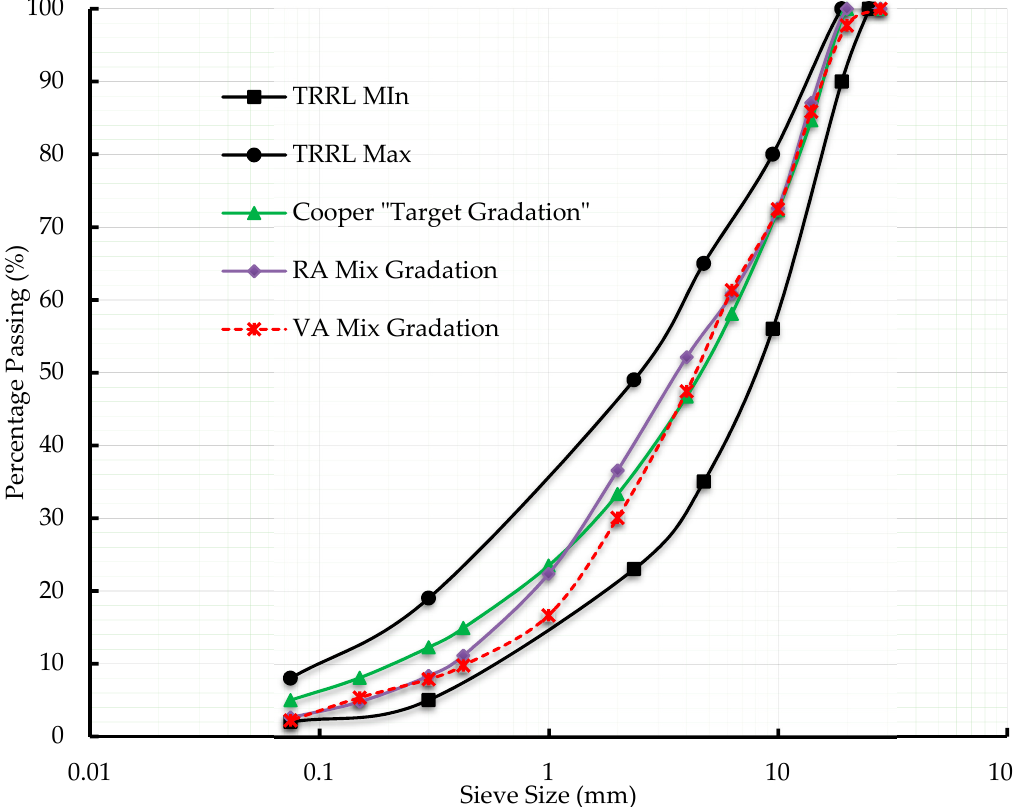
Figure 1. Design Gradations for Virgin Aggregates and Reclaimed Asphalt Aggregates Blends.